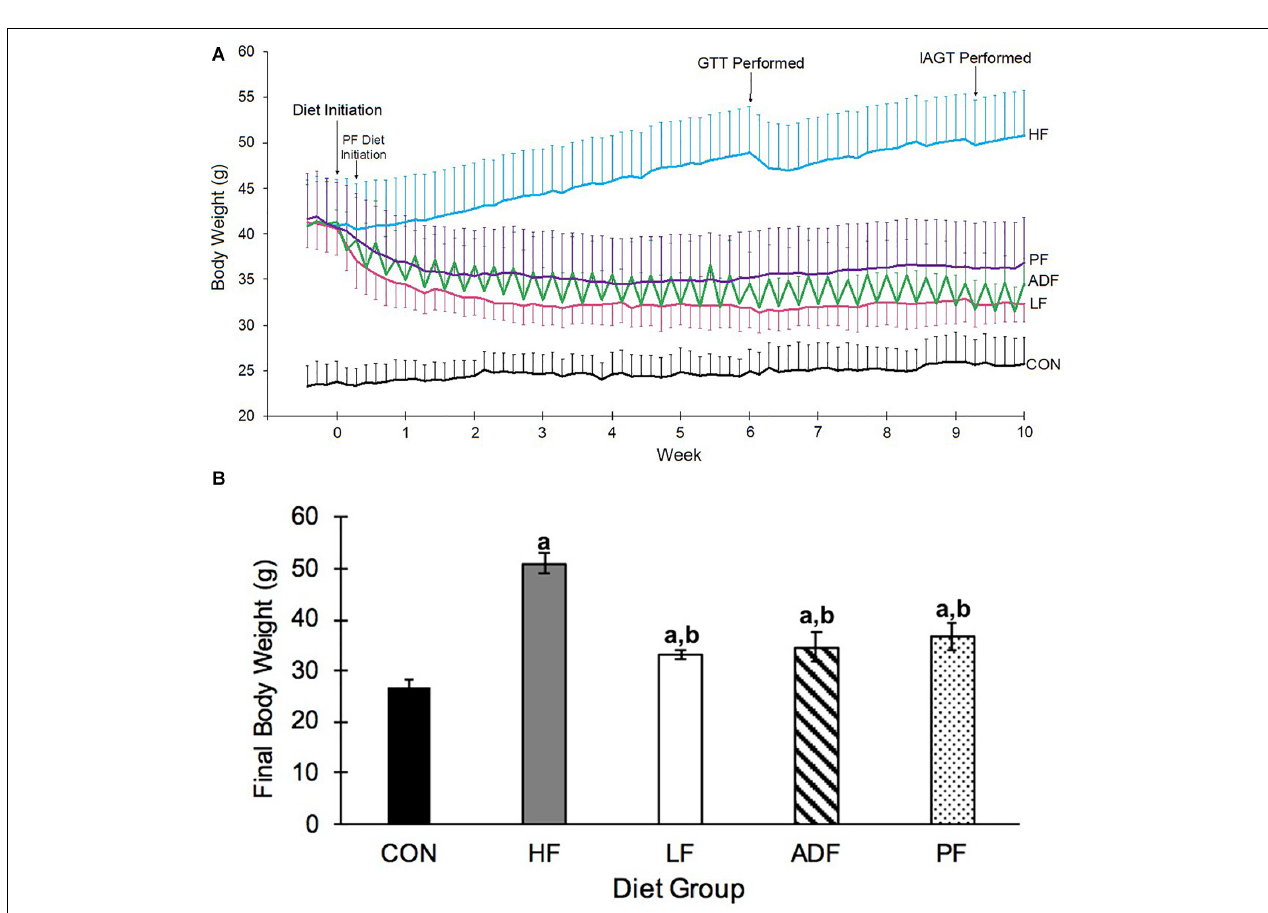
FIGURE 2 | Changes in body weight. (A) Body weight over 10 weeks of designated diet. Mice on the high-fat diet leading up to the dietary manipulation weighed 41.0 ± 3.3 g. The alternate-day-fast on a high-fat diet (ADF: green) and the switch to ad libitum chow diet (LF: pink) commenced at Day 0, whereas the pair fed group (PF: purple) that received the same amount of high-fat food as the ADF, began on Day 2. The other two groups of mice were those that remained ad libitum on the high-fat diet (HF: blue), and the mice that were maintained on an ad libitum chow diet (CON: black). The daily variation in BW of the ADF group was due to alternating days of feeding and fasting. Mice were weighed daily in the hour before the onset of the dark phase. (B) Body Weight on last experimental day. Alternate day fasting, caloric restriction, and switching to a chow ad libitum diet all led to a significantly lower BW as compared to the BW of HF ad lib diet-induced obese mice. Body weights shown are after a 6 h fast and after a fed day for ADF mice on the last experimental day. a: p < 0.05 vs. CON; b : p < 0.05 vs. HF.